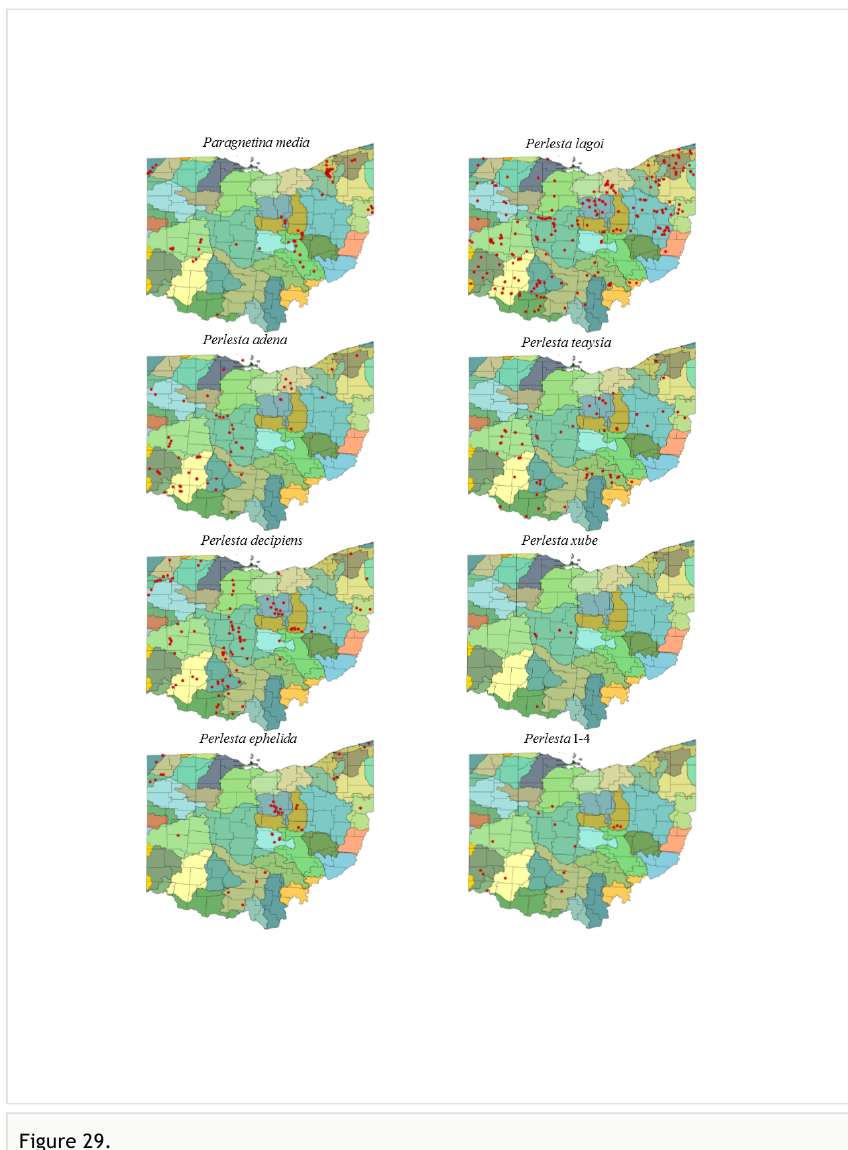
Figure 29. Distribution of Perlidae in